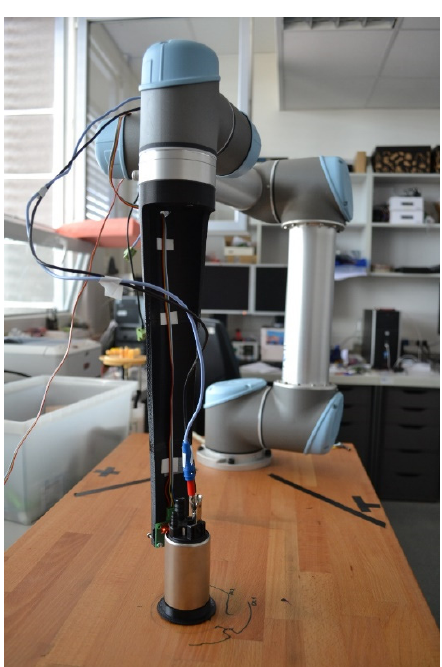
Figure 2. UR10e robotic arm during the experimental measurement with a small DC brushed